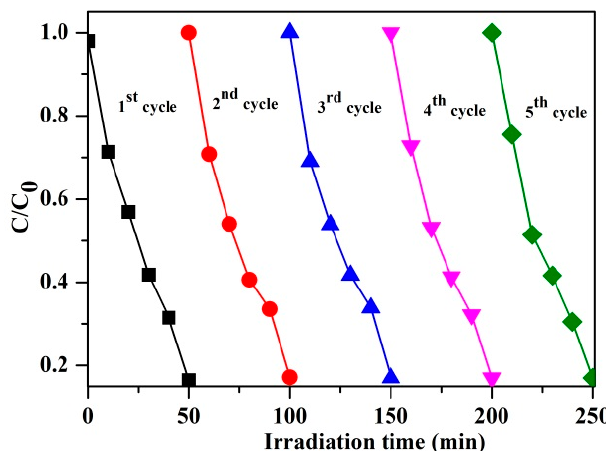
Figure 7. Cycling experiments of NTNT for MB degradation under visible light irradiation.